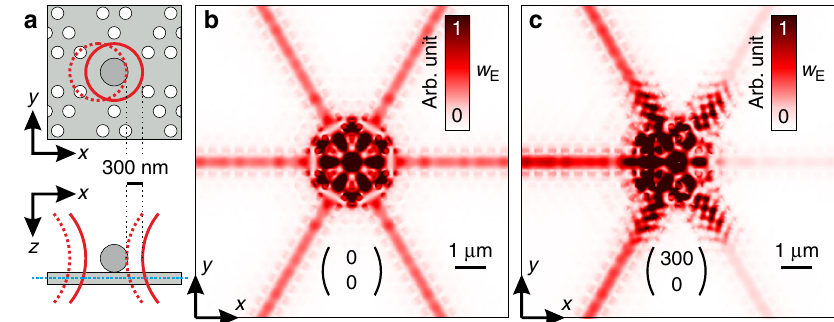
Fig. 4 Finite-difference-time-domain simulations of the position-dependent waveguide coupling. a Top-view (upper panel) and side-view (lower panel) sketch of the simulation geometry. The Si antenna is shown in dark gray and the PCW crossing in light gray. The excitation beam is indicated by solid (beam in the center) or dashed (beam shifted by 300 nm) red lines. The plane of observation is marked by the dashed blue line in the side-view sketch. b , c Numerically calculated distributions of the total electric fi eld energy density w E for the beam being in the center and the beam being shifted with respect to the sample by 300 nm along the x -axis.